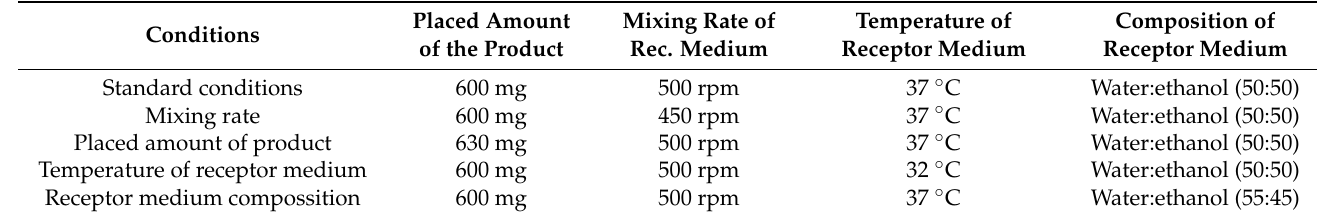
Table 1. Operational parameters of the IVRT study